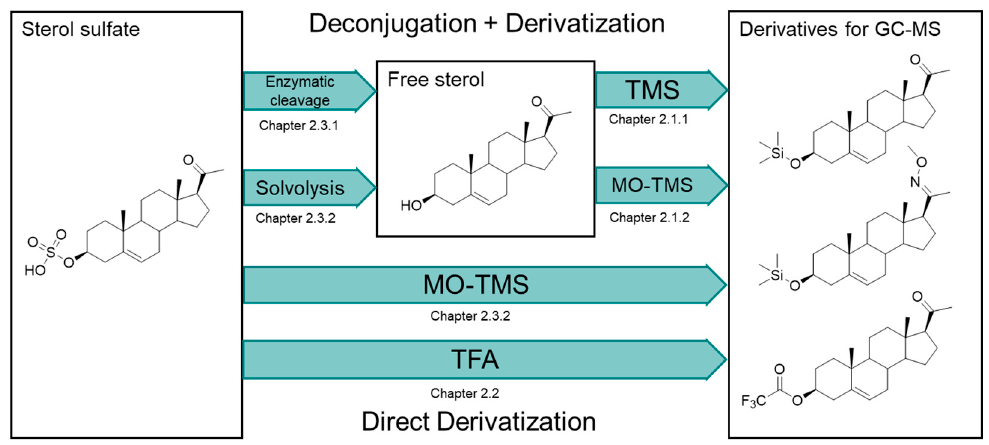
Figure 1. Strategies for sterol sulfate determination utilizing gas chromatography-mass spectrometry (GC-MS). “Two step” methods make use of a prior deconjugation step to form the free (unconjugated) sterol and a subsequent derivatization of the hydroxyl and, for methyloxime-trimethylsilyl (MO-TMS) derivatives, also the keto group. Direct derivatization refers to simultaneous cleavage of the sterol sulfate and derivatization. The deconjugation and derivatization strategies are shown with pregnenolone sulfate ( 6 ) here. TMS = derivatization to pregnenolone trimethylsilyl ether, MO-TMS = deconjugation/derivatization to pregnenolone methyloxime-trimethylsilyl ether, TFA = deconjugation/derivatization to pregnenolone trifluoroacetyl ester.